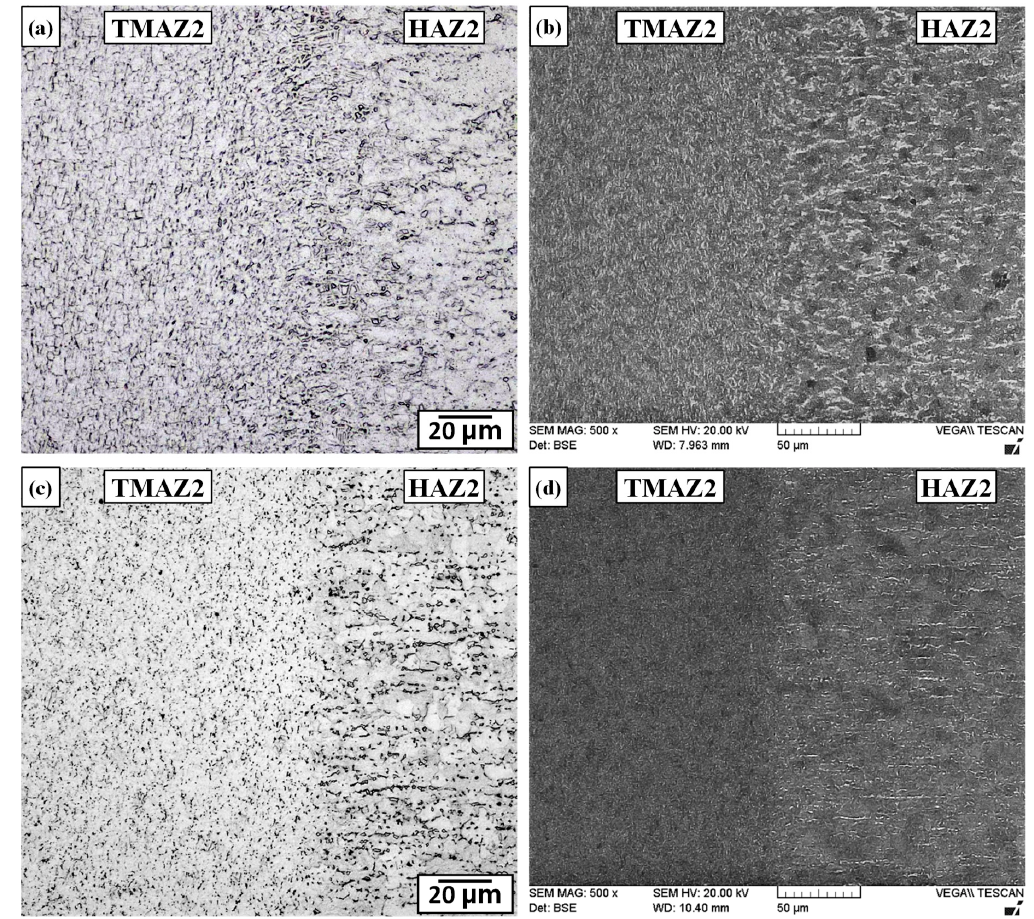
Figure 9. Microstructures in TMAZ2 between the CWZ and HAZ2 next to the Ti-64 PM ( a , b ) AWed (OM and SEM) ( c , d ) SRAed (OM and SEM). (OM and SEM) ( c , d ) SRAed (OM and